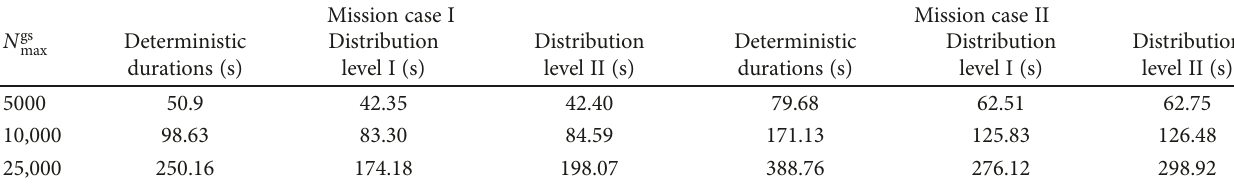
Table 15: Comparison of average CPU